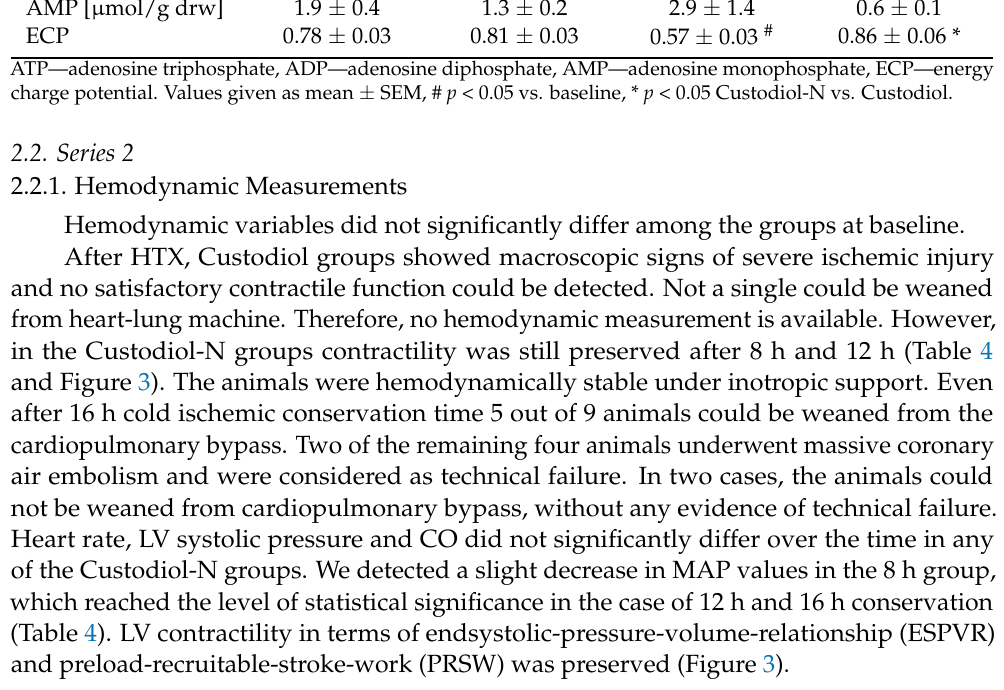
Table 4. Hemodynamic variables before and 2 h after orthotopic transplantation (Series 2: long conservation